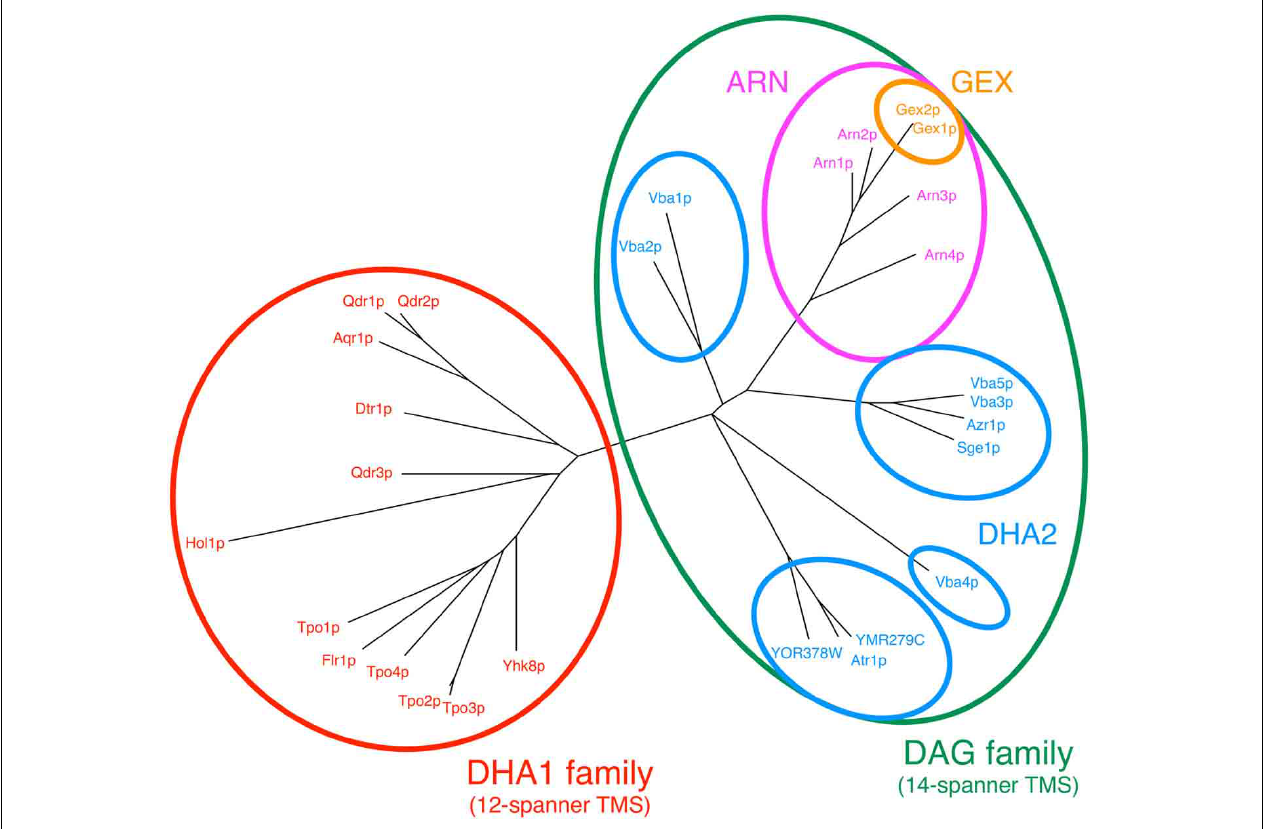
FIGURE 1 | Phylogenetic tree constructed using the amino acid sequences of DHA1 and DAG proteins encoded in the genome of the model-organism S. cerevisiae . The multiple alignments of the protein